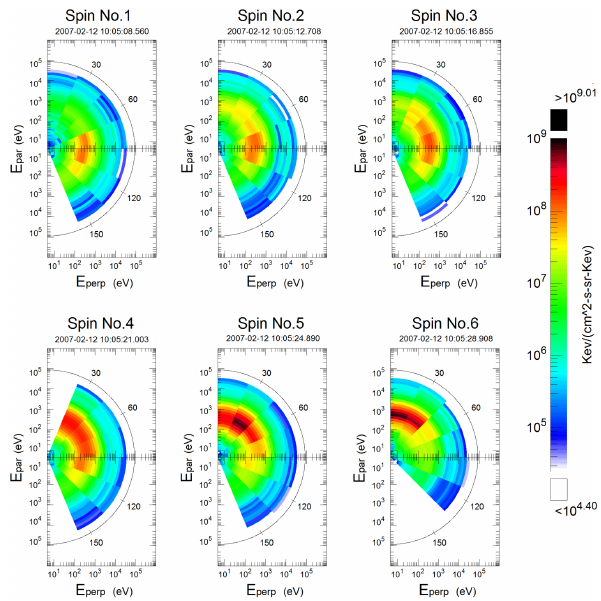
Figure 8. Ion pitch angle distribution in parallel–perpendicular en- ergy space, for six spins of Cluster 1, inside the observed FTE. Each panel shows the ion flux averaged over the two sweeps of CIS HIA instrument which bracket the time the sensor looks in the convec- tion direction. Due to variation in magnetic field orientation, one or two pitch angle zones are missing. In spin No. 1, ions are ob- served to be moving predominantly perpendicular to the magnetic field ( E × B drift effect), where the maximum flux has a kinetic en- ergy of ∼ 300eV. In the next two spins, No. 2 and No. 3, the peak energy rises to ∼ 400eV, and has parallel component as well. In spin No. 4, a broader range of ion PAD from 0 to 90 ◦ is observed, along with an increase in the energy band containing the peak flux of the ions, up to 1.2keV. One spin later, in spin No. 5, the ion peak energy increased to ∼ 500–600eV, with a parallel component larger than the perpendicular (identical to pitch angle 33.75 ◦ ). Finally, in the last spin, No. 6, the ions are observed to be moving mainly par- allel to the magnetic field with peak energy of ∼